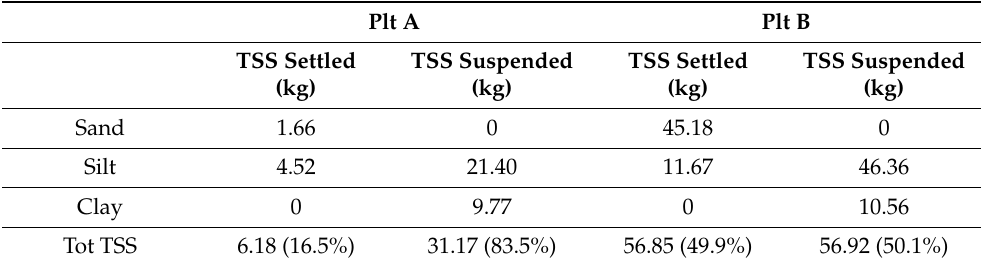
Table 6. TSS discharged fate around platform A and B during the monthly